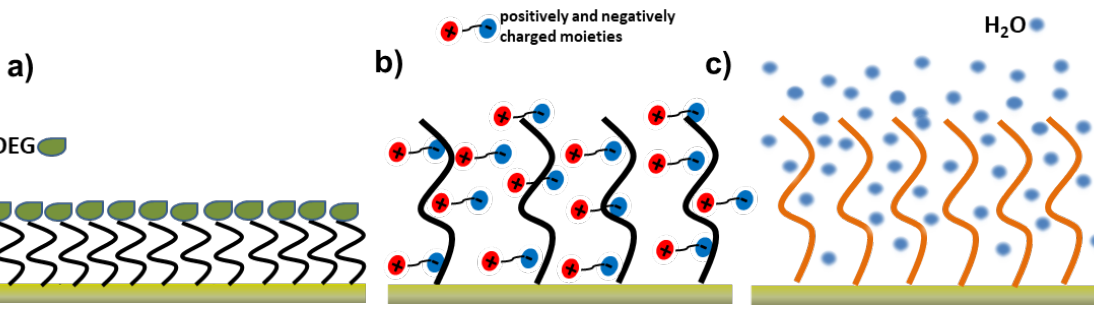
Figure 2. Pictorial illustration of some of the antifouling layers: ( a ) SAM presenting OEG, ( b ) zwitterionic, and ( c ) hydrogel polymers.